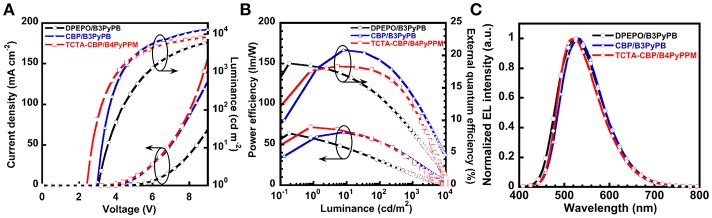
OLED performances of optimized 2PXZNN-based devices. (A)
J–V–L characteristics. (B)
ηext-L characteristics. (C) EL spectra at 1 mA.